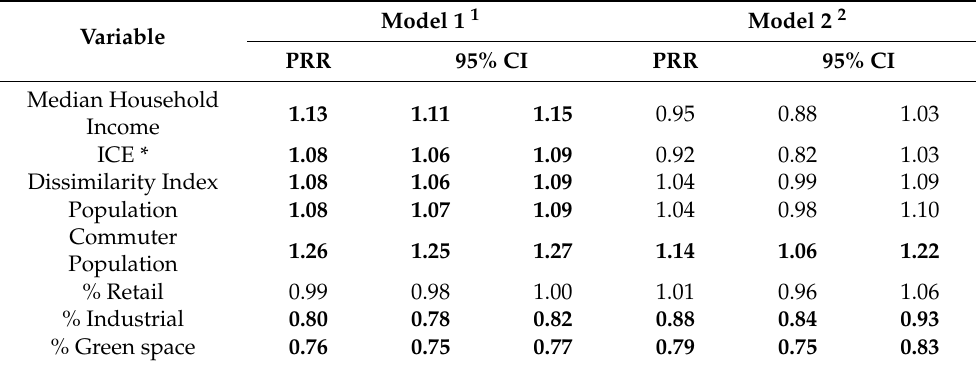
Table 2. Multilevel Bayesian conditional autoregressive Poisson models estimating the prevalence rate ratio for counts of litter bins. Model 1 1 Model 2 2 Variable PRR 95%